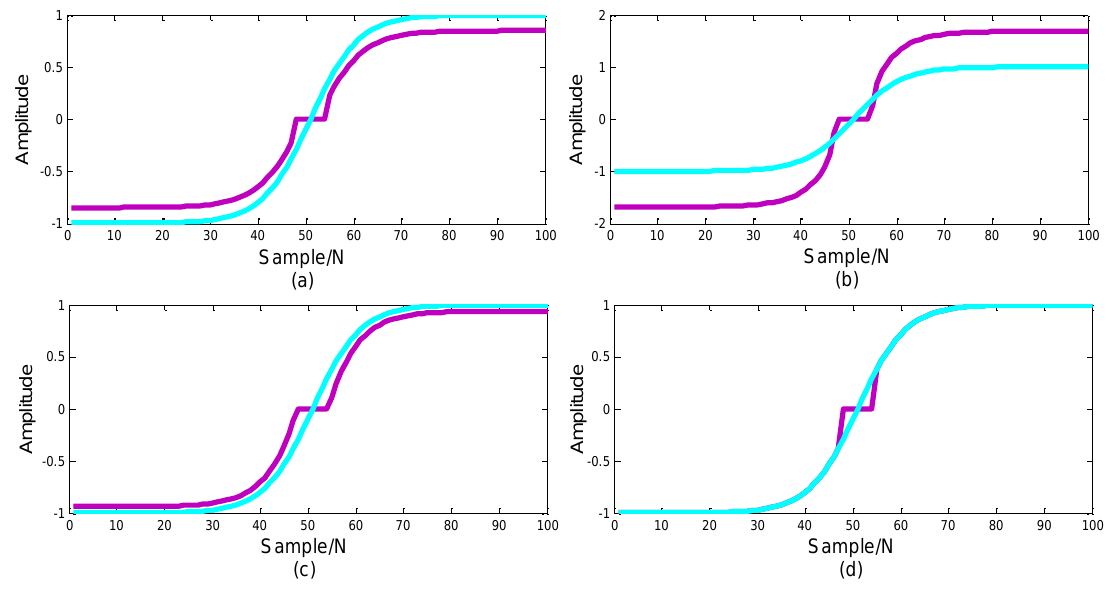
Figure 2. Comparison of threshold processing results: ( a ) Threshold function processing result of Equation (11); ( b ) Threshold function processing result of Equation (12); ( c ) Threshold function processing result of Equation (13); and ( d ) Threshold function processing result of Equation (15). The residual white noise in the reconstructed PD signal was then suppressed using the improved wavelet packet threshold method.